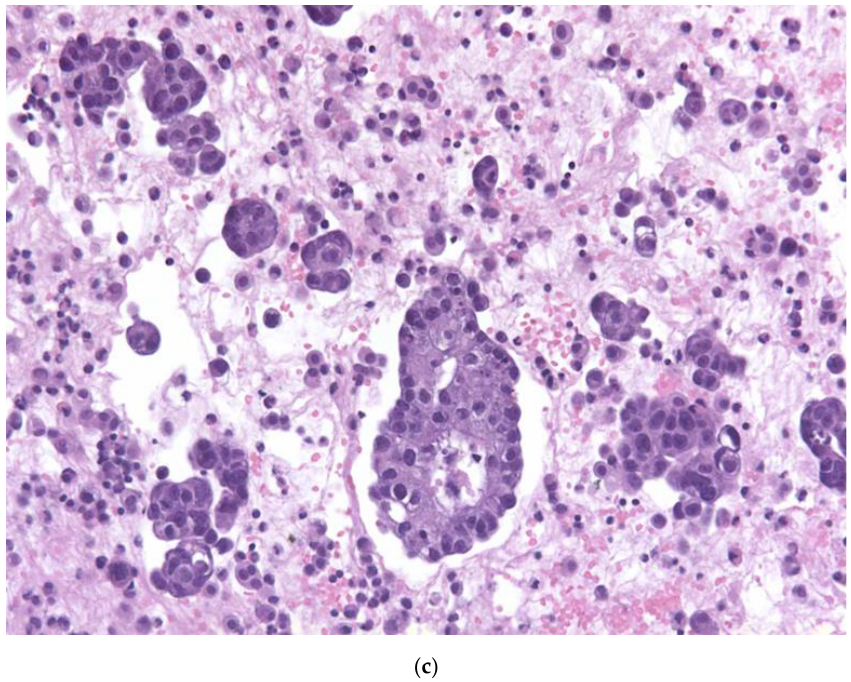
Figure 1. ( a ) Cytology smear of a liver fine-needle aspiration shows metastatic ductal carcinoma